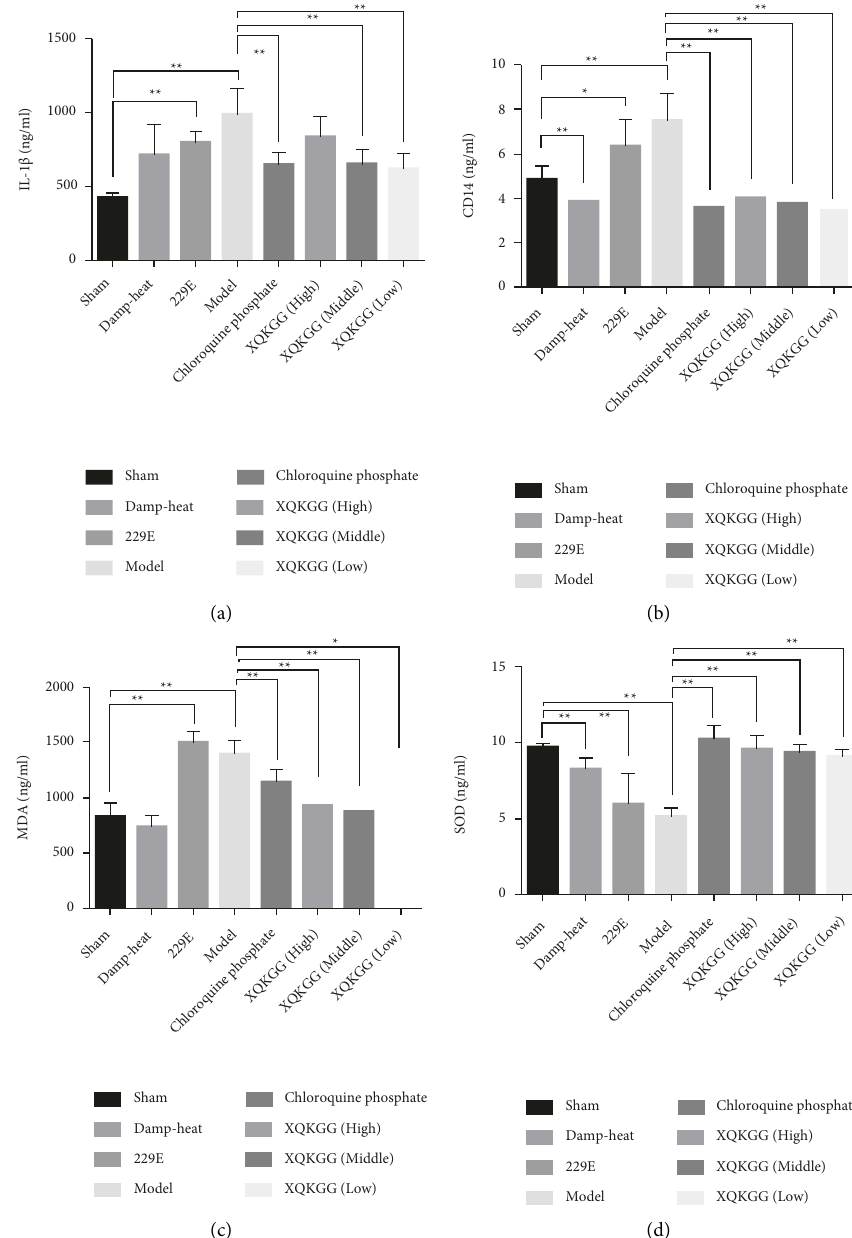
Figure 2: Comparison of the cytokines of IL-1 β (a), CD14 (b), MDA (c), and SOD (d) in rat lung tissue with the method of ELISA. Comparison between the sham group and the 229E group with a level of IL-1 β ( P < 0 . 01), CD14 ( P < 0 . 05), MDA ( P < 0 . 01), and SOD ( P < 0 . 01); comparison between the sham group and the model group with a level of IL-1 β ( P < 0 . 01), CD14 ( P < 0 . 01), MDA ( P < 0 . 01), and SOD ( P < 0 . 01); comparison between the model group and the chloroquine phosphate group/high and middle doses of XQKGG groups with the level of IL-1 β ( P < 0 . 01), CD14 ( P < 0 . 01), MDA ( P < 0 . 01), and SOD ( P < 0 . 01); comparison between the model group and a low dose of XQKGG group with a level of IL-1 β ( P < 0 . 05), CD14 ( P < 0 . 01), MDA ( P < 0 . 05), and SOD ( P < 0 .